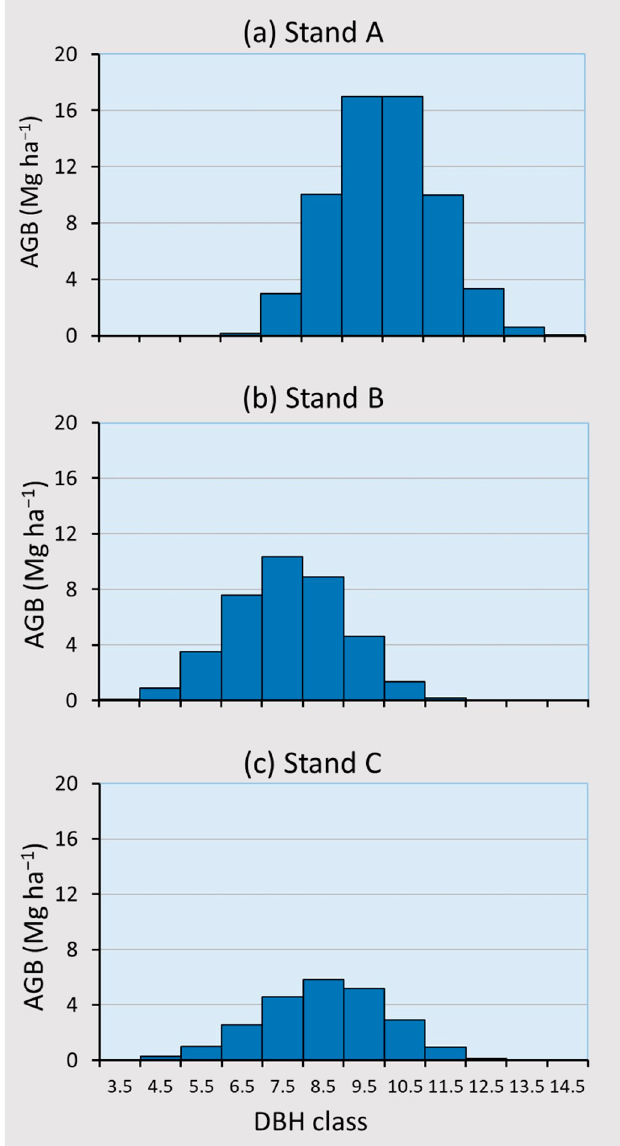
Figure 4. The aboveground biomass (AGB) predicted by the diameter distribution model for the three stands of Ma bamboo, where the stand diameter distribution predicted by the Weibull function and the a , b and c parameters were predicted to be 1.53, 5.80 and 2.94; 1.80, 5.39 and 4.15; 4.50, 7.00 and 3.60 for stands A, B and C, respectively. These parameters were cited from Sun and Yen [14], and the biomass equation (Equation T–A) was used to predict AGB for each diameter class.